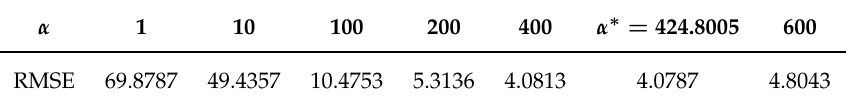
Table 7. The RMSE of the RBF least squares approximation on different shape